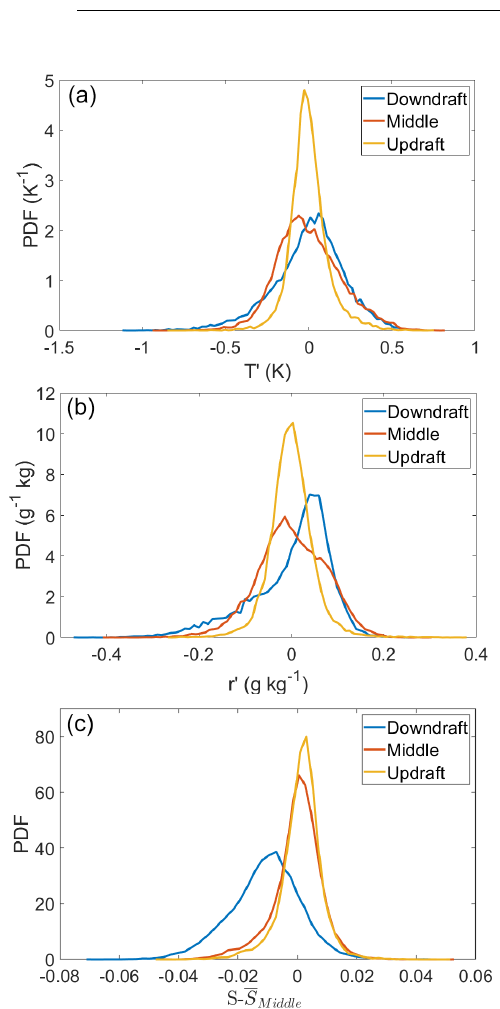
Figure 13. The probability distributions of T (cid:48) (a) , r (cid:48) (b) , and S − S middle (c) near the updraft, downdraft, and middle. For each region, a high-pass filter was applied to r and T with a cutoff of ≈ 5min to remove low frequency oscillations due to the slight drift in the chamber controls. We have plotted the distributions S − S middle , not S (cid:48) , to highlight the fact that the downdraft has a lower mean relative the middle and